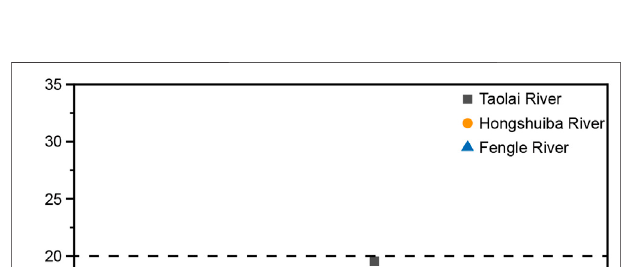
FIGURE 9 | Downstream variation in the ratio of those grain-size groups with D/D 50 in the range between 0.3 and 4.2 to all the clasts collected at each site.Differentsymbolsareusedforthethreestudyrivers.Itcanbeclearlyseen that this ratio is maintained in the narrow range 0.66 – 0.82 moving